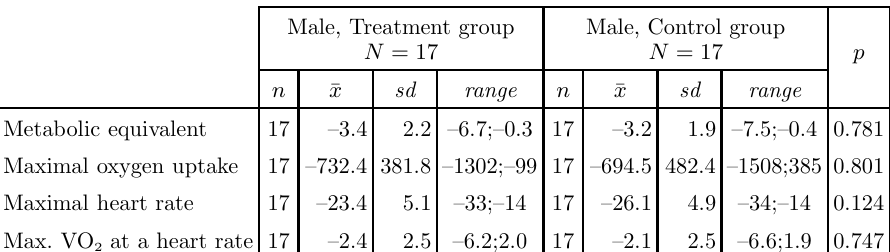
Table 2. Comparison of cardiovascular parameters between the treatment group and the control group for the male subgroup